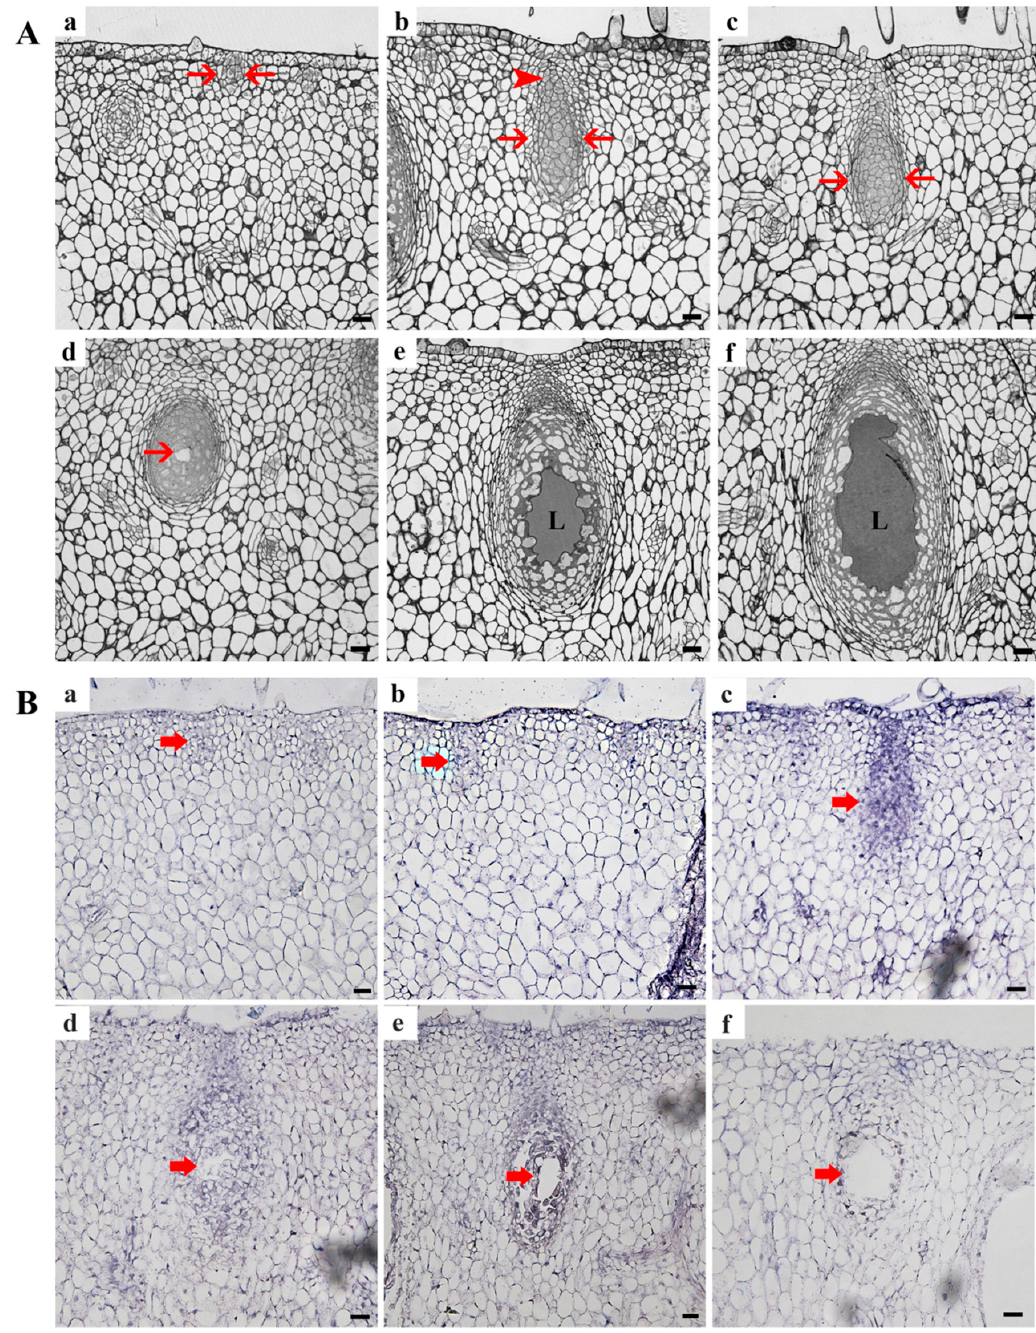
Figure 3. Microscopic results and in situ hybridization analysis of the secretory cavity at different developmental stages of Citrus grandis ‘Tomentosa’ fruits. ( A ) Microscopic structure of the secretory cavity in different developmental stages in the exocarp of Citrus grandis ‘Tomentosa’ fruits. The initial cell stage of the secretory cavity in ( a – c ). ( a ) The early initial cell stage (arrow). ( b ) The middle initial cell stage. A globular part (arrow) and a conical cap part (arrowhead). The cytoplasm of the center cell in the globular part is dense. ( c ) The late initial cell stage. Cytoplasm thinning in the central cell of the globular part (arrow). ( d ) The lumen-forming stage. The arrow represents the newly formed lumen. ( e , f ) The lumen-expanding stage. The arrow shows the secretory cavity. ( B ) In situ hybridization analysis of CgENDO1 during the development of the secretory cavity. ( a – f ) In situ hybridization signals in secretory cavity cells at different developmental stages. The signals are strongest in the late initial cell stage ( c ), weakened in the lumen-forming stage ( d ) and the lumen-expanding stage ( e , f ), and weak in the early initial cell stage ( a ) and the middle initial cell stage ( b ). L: Lumen. Bars = 20 µ